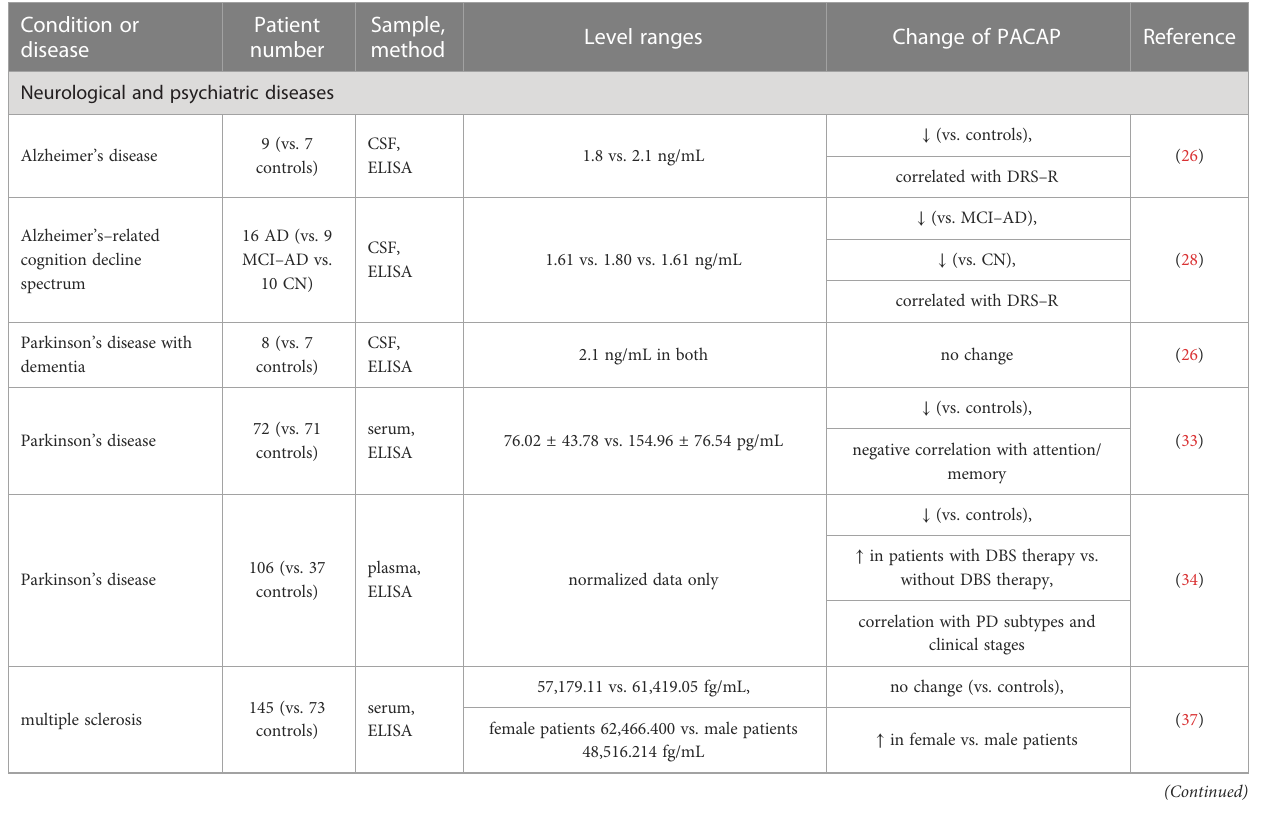
TABLE 1 Changes in PACAP levels in human pathological